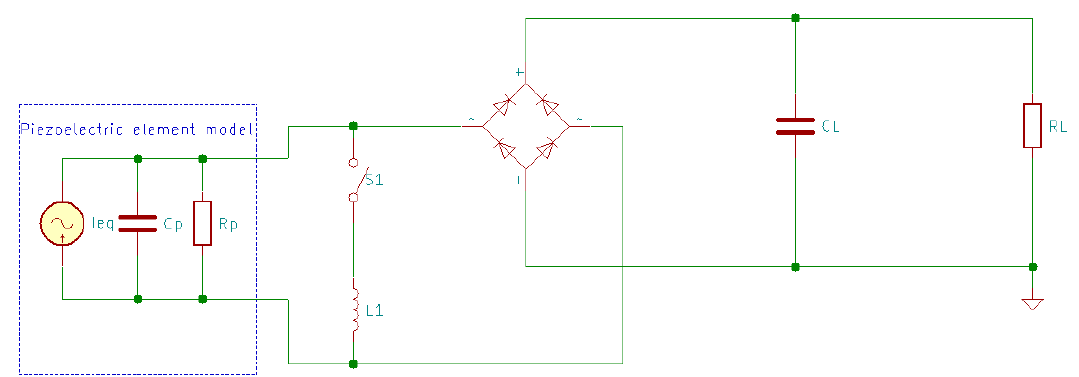
Figure 19. Parallel-Synchronized Switch Harvesting on Inductor (SSHI) energy harvesting circuit.